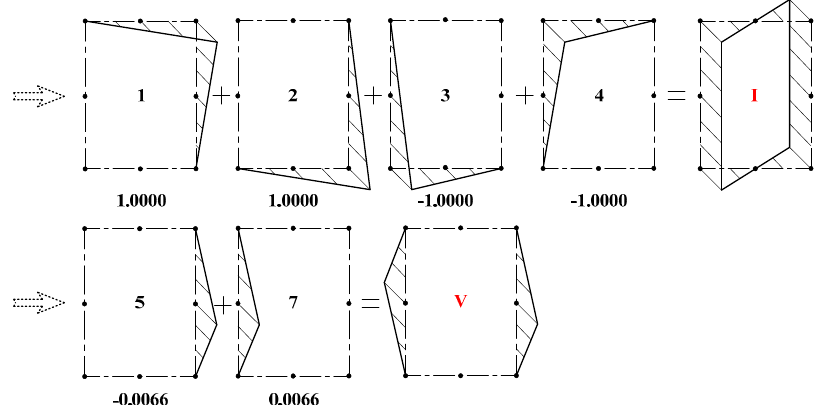
Figure 7. Assemblage of out-of-plane mode family for the first modal of a thin-walled structure with a rectangular hollow cross-section.